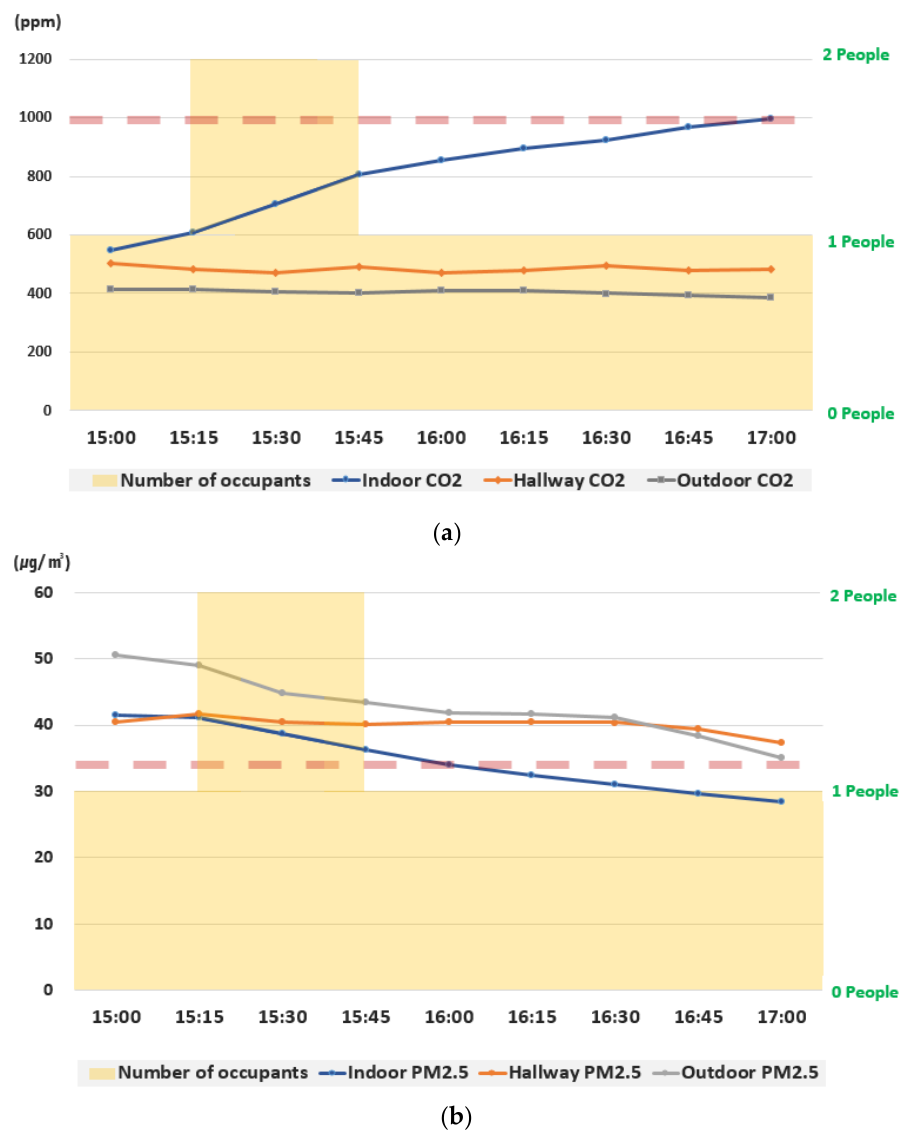
Figure 7. Concentration measurement of ( a ) CO 2 and ( b ) PM2.5 on 20 April 2021.